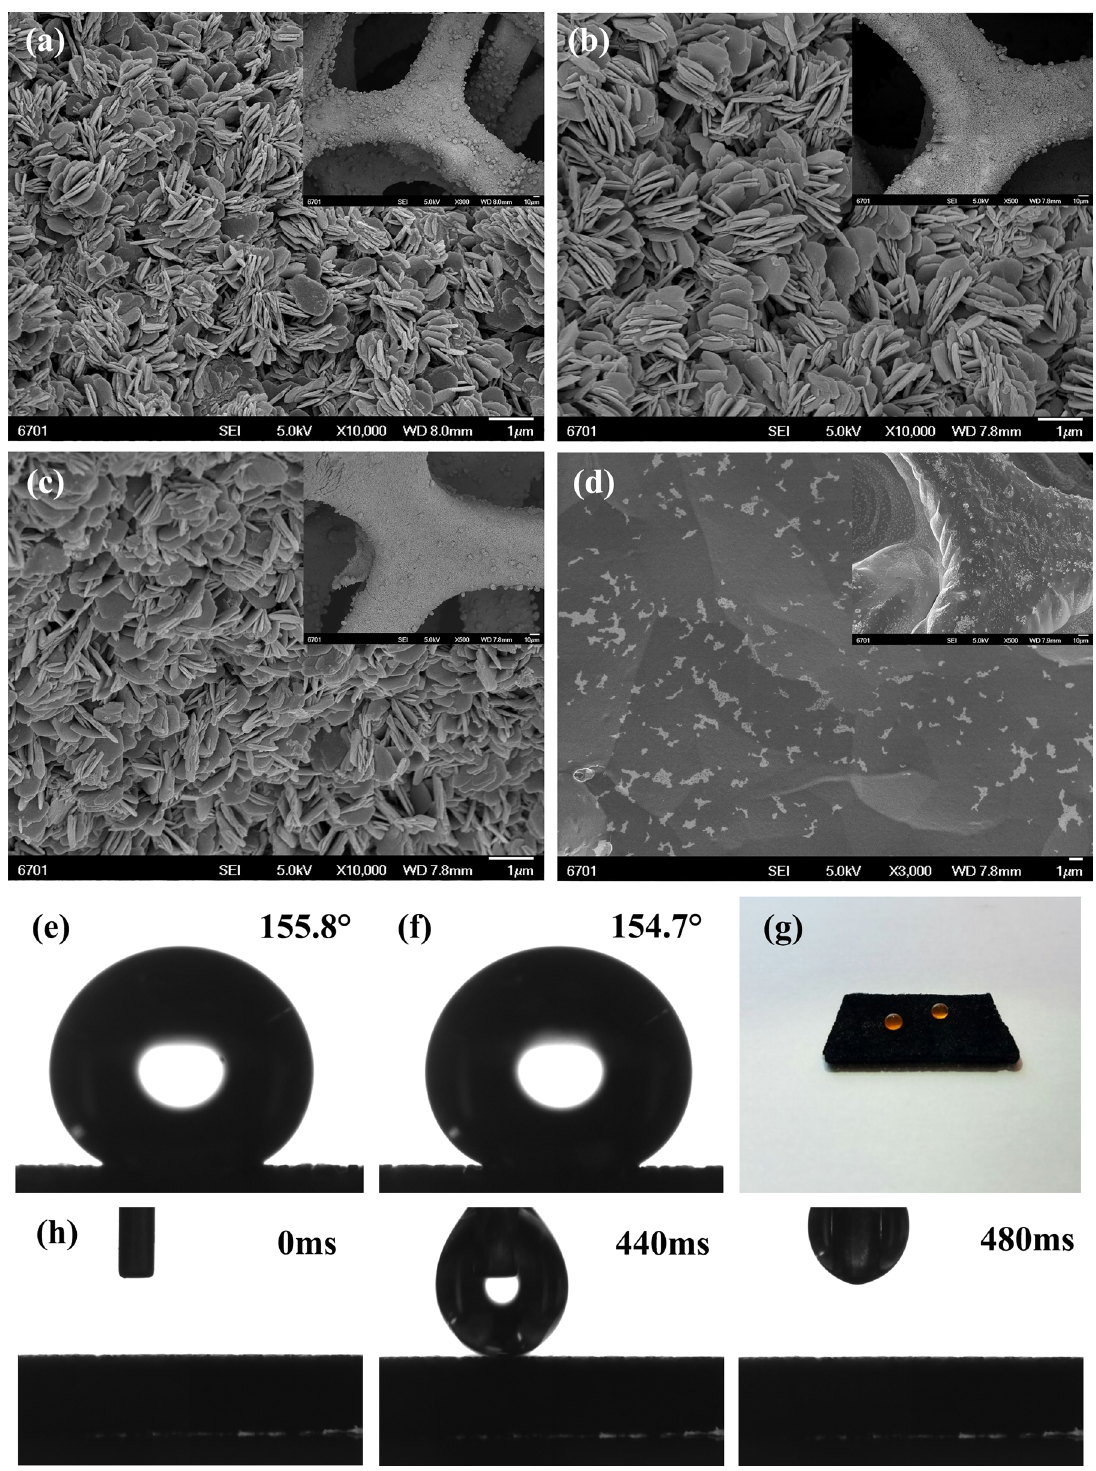
Figure 1. SEM images of OCF (a), PDMS-OCF (b), SA-OCF (c) and PDMS-OCF/paraffin composite (d); water CA images of PDMS- OCF (e) and SA-OCF (f); the image of PDMS-OCF on the water and two drops of helianthin B on it (g), oil CA images of